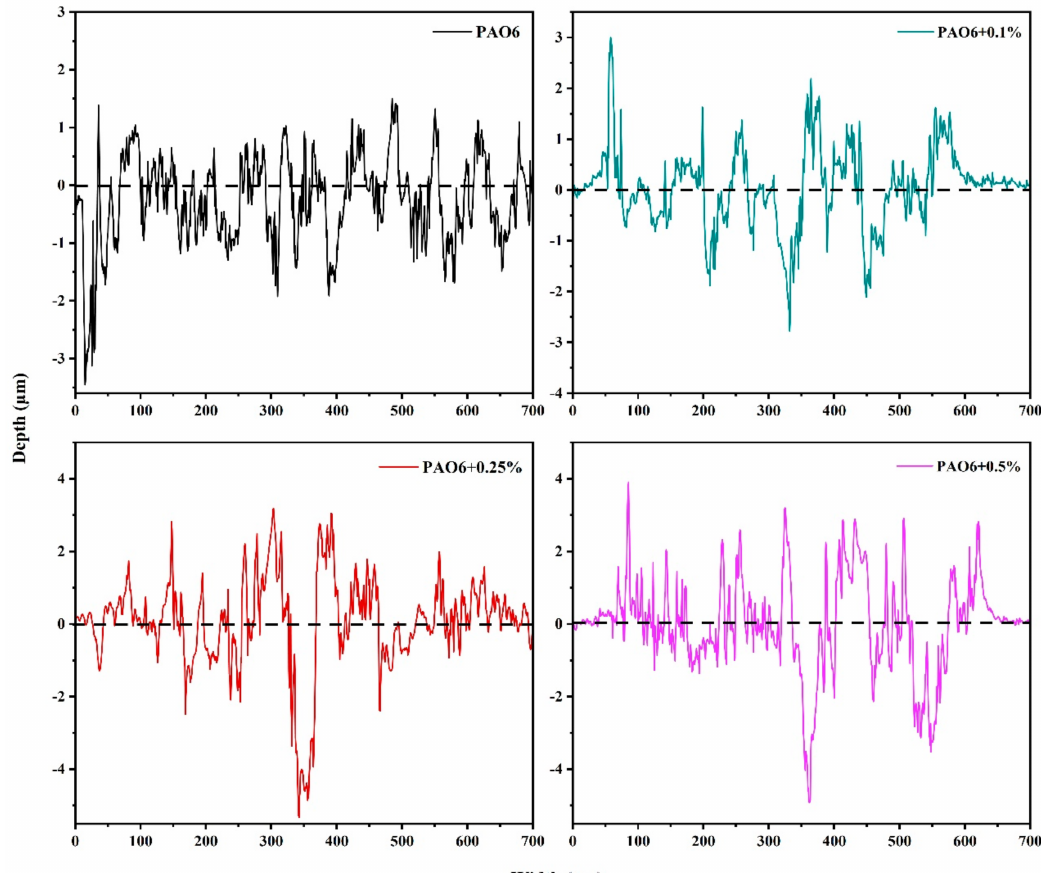
Figure 8. Contours of wear marks of MnO 2